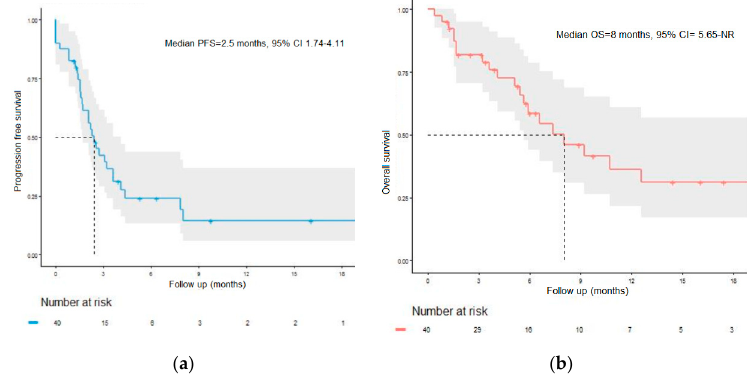
Figure 1. Survival in the BRAF-mutant subgroup . ( a ) Progression-free survival in the BRAF-mutant subgroup . PFS: progression-free survival . ( b ) Overall survival in the BRAF-mutant subgroup . OS: overall survival; NR: not reached .